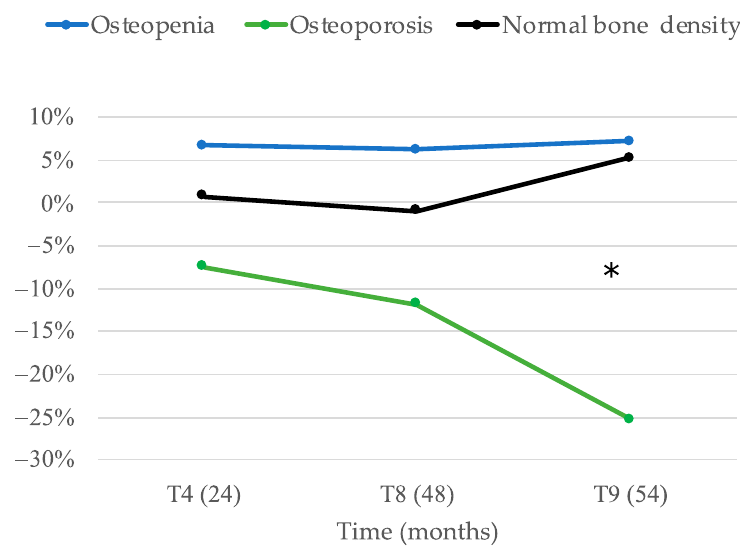
Figure 1. Percentage of change as compared to baseline of subjects with osteoporosis, osteopenia and normal bone density during treatment (* p < 0.05).